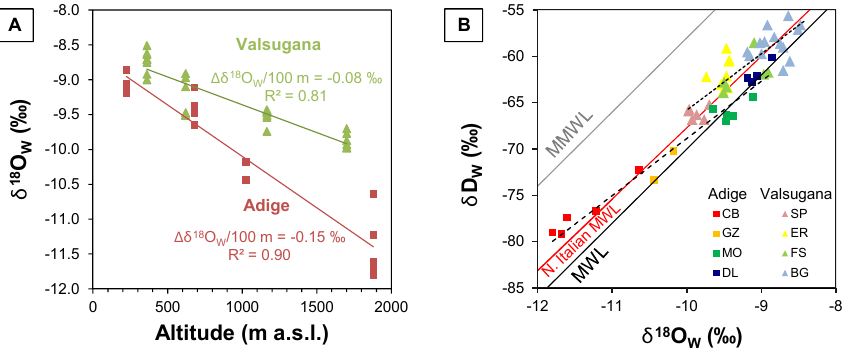
Fig. 3. Oxygen and hydrogen isotopes of the dripwaters in caves from different altitudes. (A) The oxygen isotope values deviate depending on which valley (Adige or Valsugana) the caves are situated (see Fig. 1). Hydrogen isotopes (not plotted) follow a similar pattern as the oxygen isotopes in the two valleys. (B) Dripwater oxygen vs. hydrogen isotopes align similar to the N. Italian meteoric water line (red line: Longinelli and Selmo, 2003), which lies near the global Meteoric Water Line (MWL: Craig, 1961) with a slight tendency towards the Mediterranean Meteoric Water Line (MMWL: Gat, 1996). Values align inversely with altitude, with a different trend for each valley; the Valsugana Valley